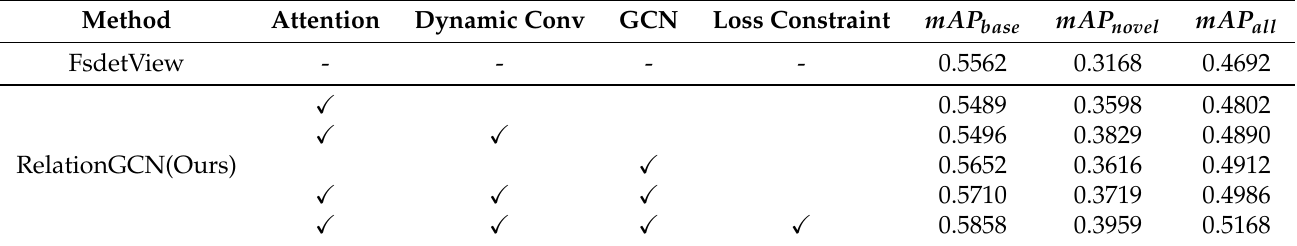
Table 4. Ablation study of different components of the proposed few-shot detection